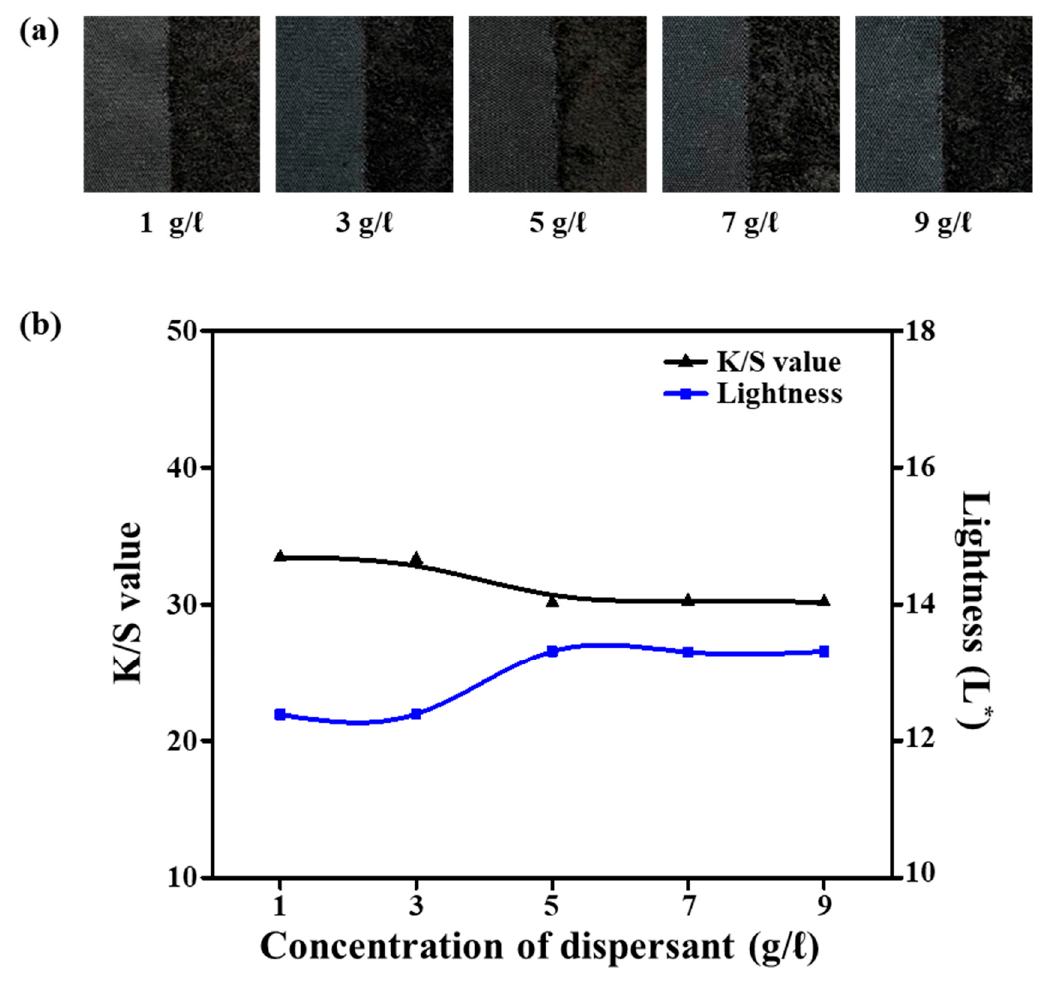
Figure 7. ( a ) Dyed samples. ( b ) K / S and lightness (L*) values according to dispersant concentration (1–9 g/L).